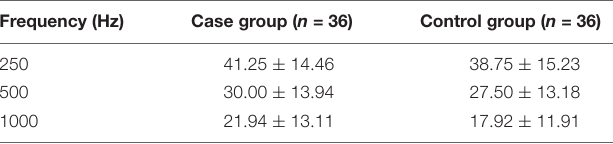
TABLE 4 | Air bone gap of case group and control